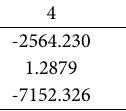
Table 2. electronic parameters of bupropion in gas and water phase by B3LYP/6-311+G(d, p) Bupropion gas Table 3. Energy and dipole momentum in Bupropion-C60 complexes